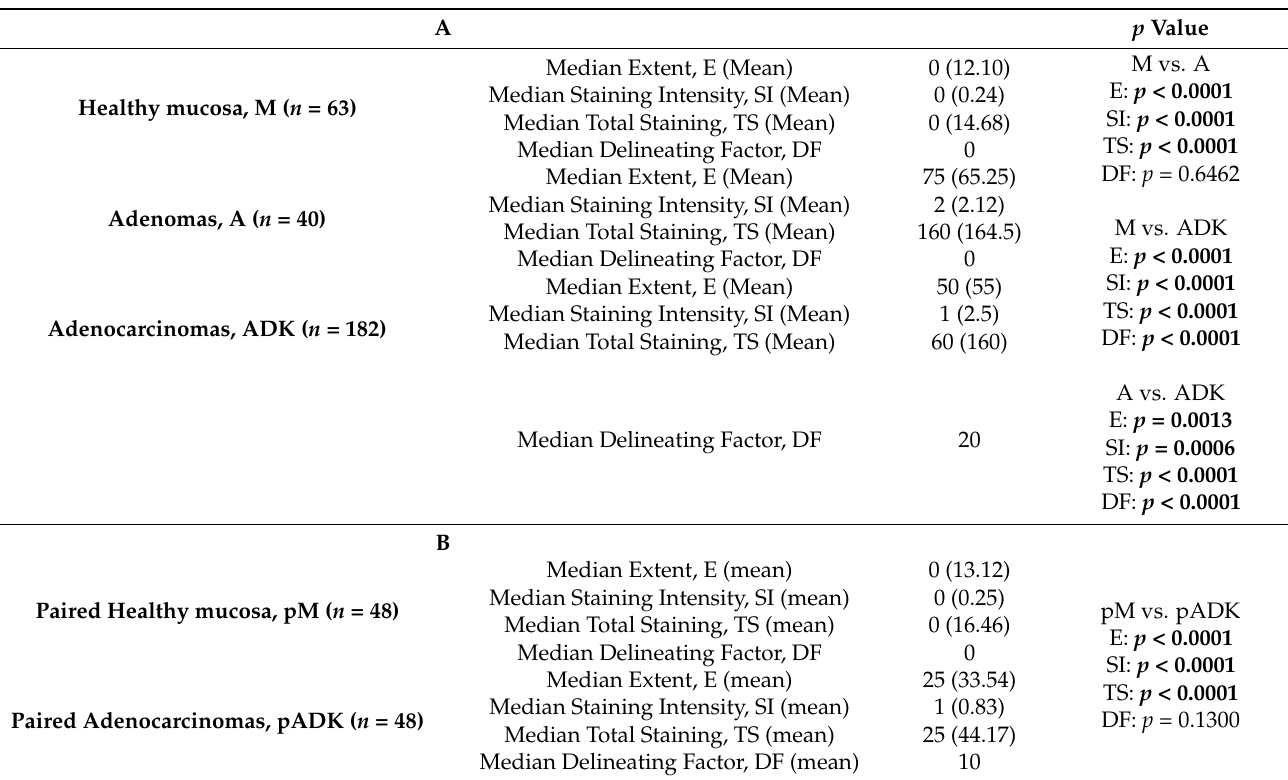
Table 1. Quantitative data (medians and means) and statistical analyses from the immunohistochemistry. (A) Healthy mucosa, adenomas and adenocarcinomas (Mann Whitney Test). Statistically significant associations ( p < 0.05) are indicated in bold. (B) Paired healthy colorectal mucosa and adenocarcinoma (Mann Whitney Test). Statistically significant associations ( p < 0.05) are highlighted in bold. The terminology used are defined in detail in the Materials and